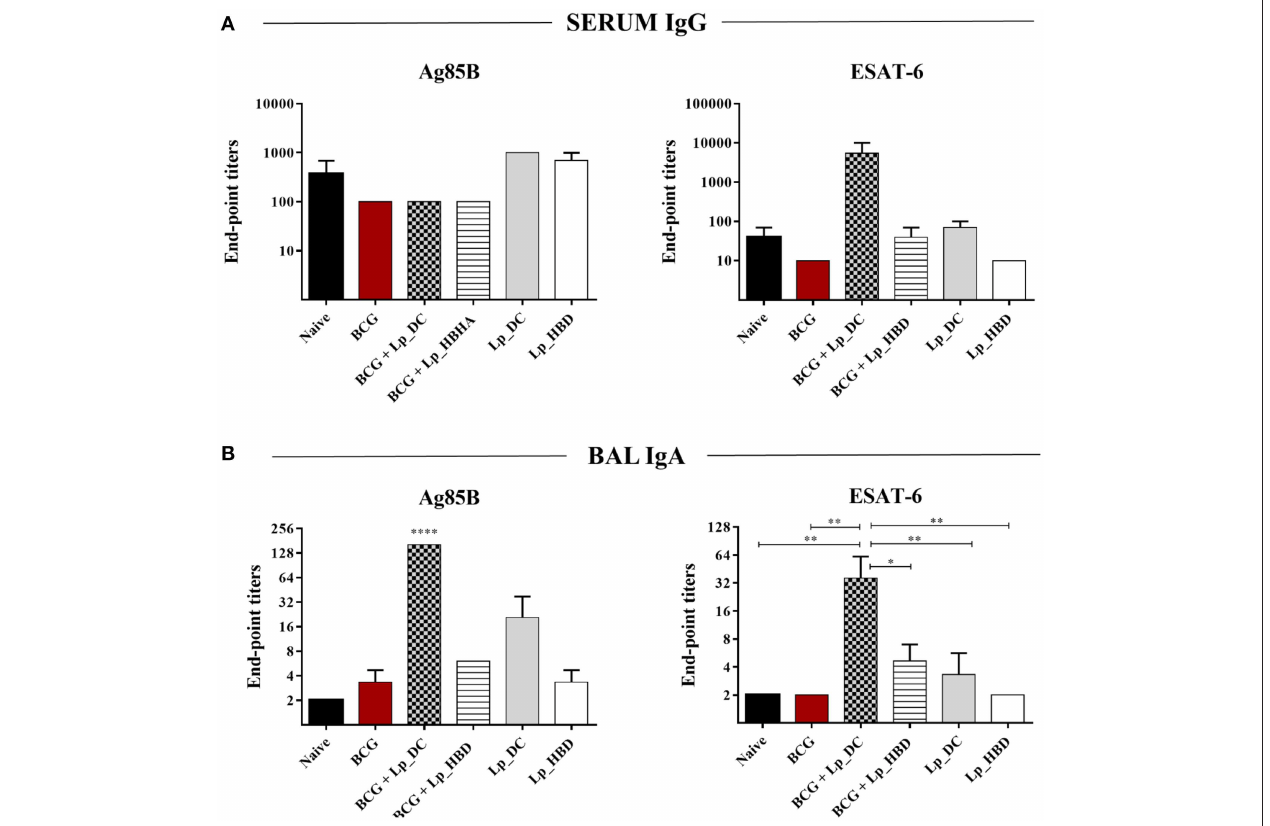
FIGURE 5 | Humoral responses induced by Lp _DC and Lp _HBD. Serial dilutions of serum (10-fold) and BAL (3-fold) samples were subjected to ELISA in order to determine antibodies specific to Ag85B or ESAT-6. The end-point titers were evaluated for serum IgG (A) and BAL IgA (B) . Results are presented as a mean ± SEM ( n = 2–3). Statistically significant differences were determined using one-way ANOVA with Tukey’s post-hoc test and are indicated as follows: * p < 0.05, ** p < 0.01, and **** p <